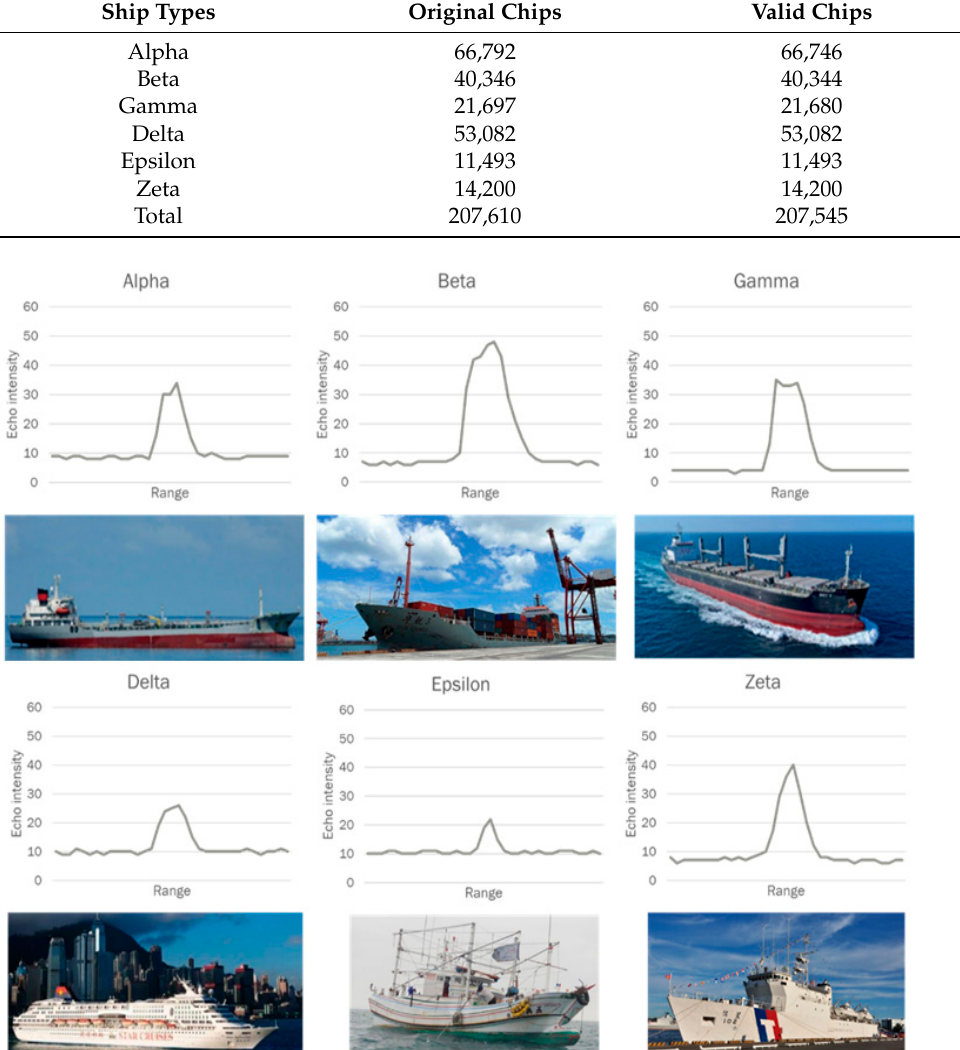
Figure 8. Six ship types and their HRRPs.